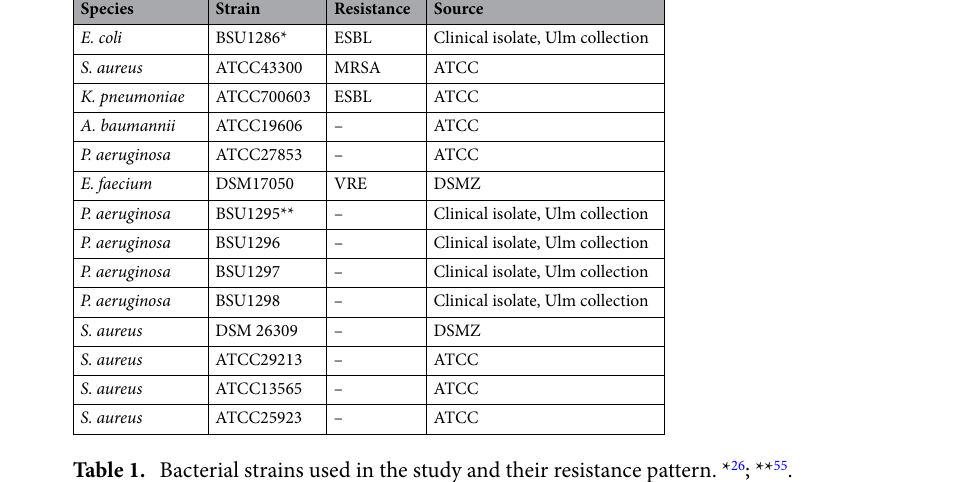
Table 1. Bacterial strains used in the study and their resistance pattern. * 26 ; ** 55